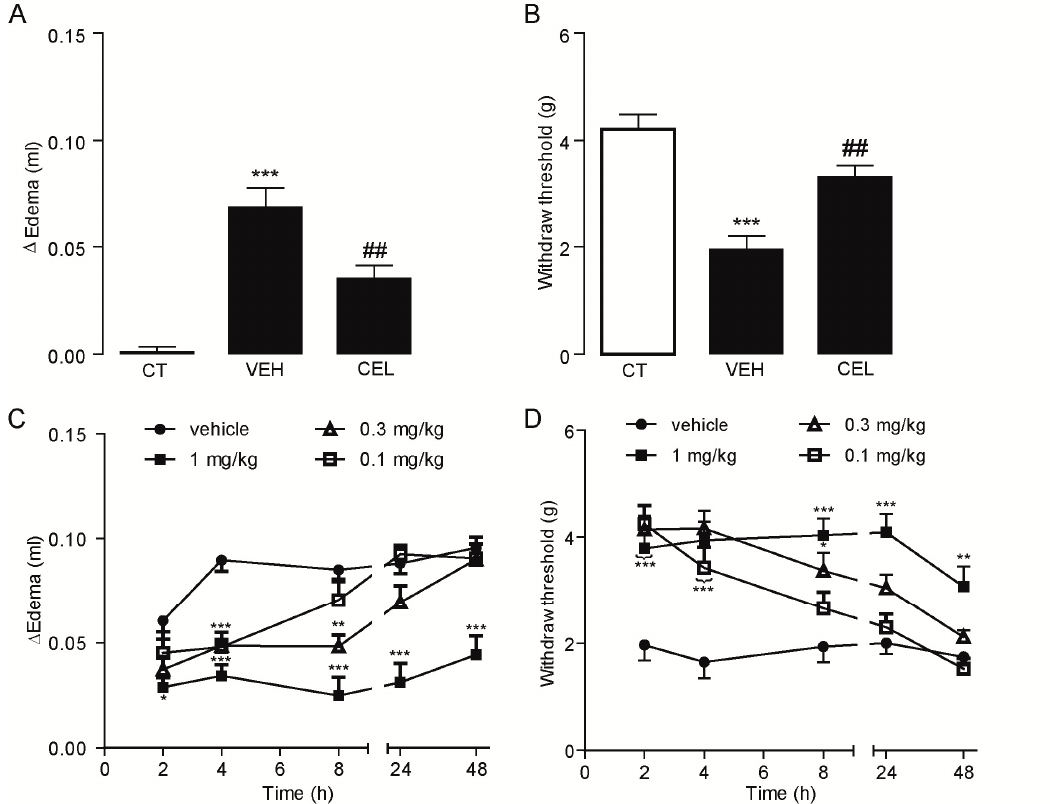
Figure 1. Celastrol reduced edema and hyperalgesia in the carrageenan-induced inflammatory pain model. The effect of vehicle (VEH, 5% PEG/5% Tween-80 in saline, 10 mL/kg, i.p.) and celastrol (CEL, 0.3 mg/kg, i.p.) on carrageenan-induced edema ( A ) and pain hypersensitivity ( B ). *** p < 0.001 vs. non-carrageenan injection (CT), ## p < 0.01 vs. VEH; one-way ANOVA followed by Bonferroni’s multiple comparison test, n = 5–6. The time- and dose-dependent effect of celastrol on carrageenan-induced edema ( C ) and pain hypersensitivity ( D ). * p < 0.05, ** p < 0.01, *** p < 0.001 vs.